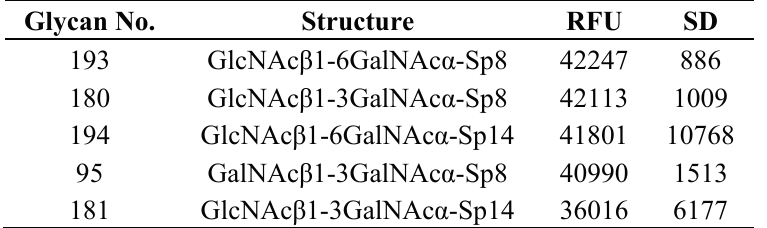
Table 2. Binding affinity of SSR1 towards substituted form of Tn antigen.